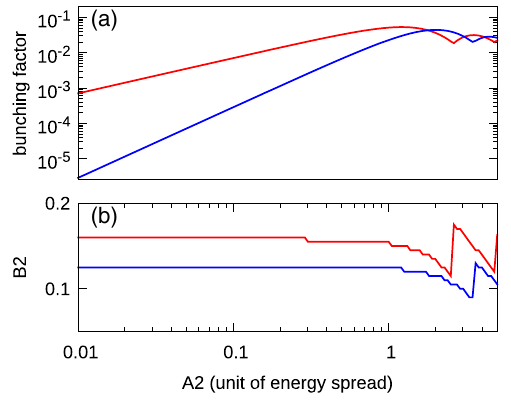
FIG. 5. (a) Bunching factor versus A 2 , from Eq. (7), with K ¼ 3 . 07 , A ¼ 5 and (red line) n ¼ 7 ; m ¼ 1 and (blue line) 1 n ¼ 7 ; m ¼ 2 . (b) Associated value of B 2 maximizing the bunching